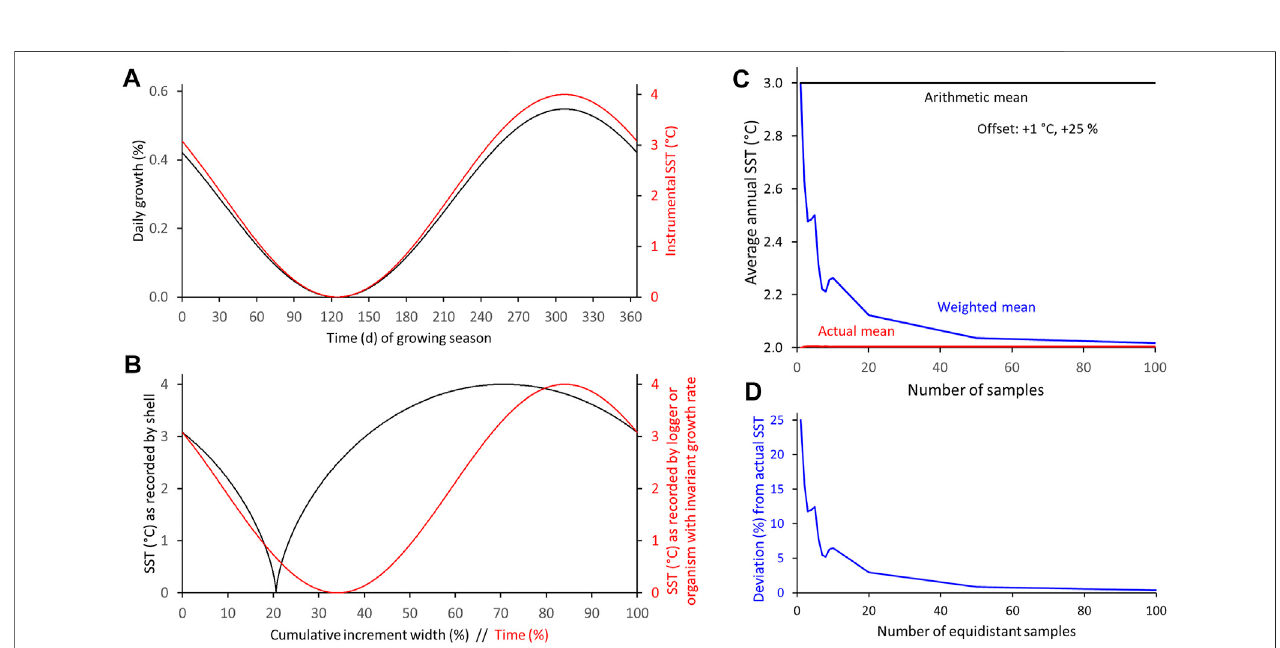
FIGURE 6 | Numerical simulation of differences between arithmetic and weighted annual means computed from intra-annual proxy-SST assuming shell growth and SST curves are in phase and have a symmetrical shape. (A) Modeled seasonal shell growth and SST. (B) SST as recorded by model shell and logger. (C,D) Arithmeticandweightedannualproxy-SSTincomparisontoactualSSTmean.Withincreasingsampleresolution,theweightedmeanagreesbetterwiththeinstrumental SST average (C) : absolute values; (D) : relative values.